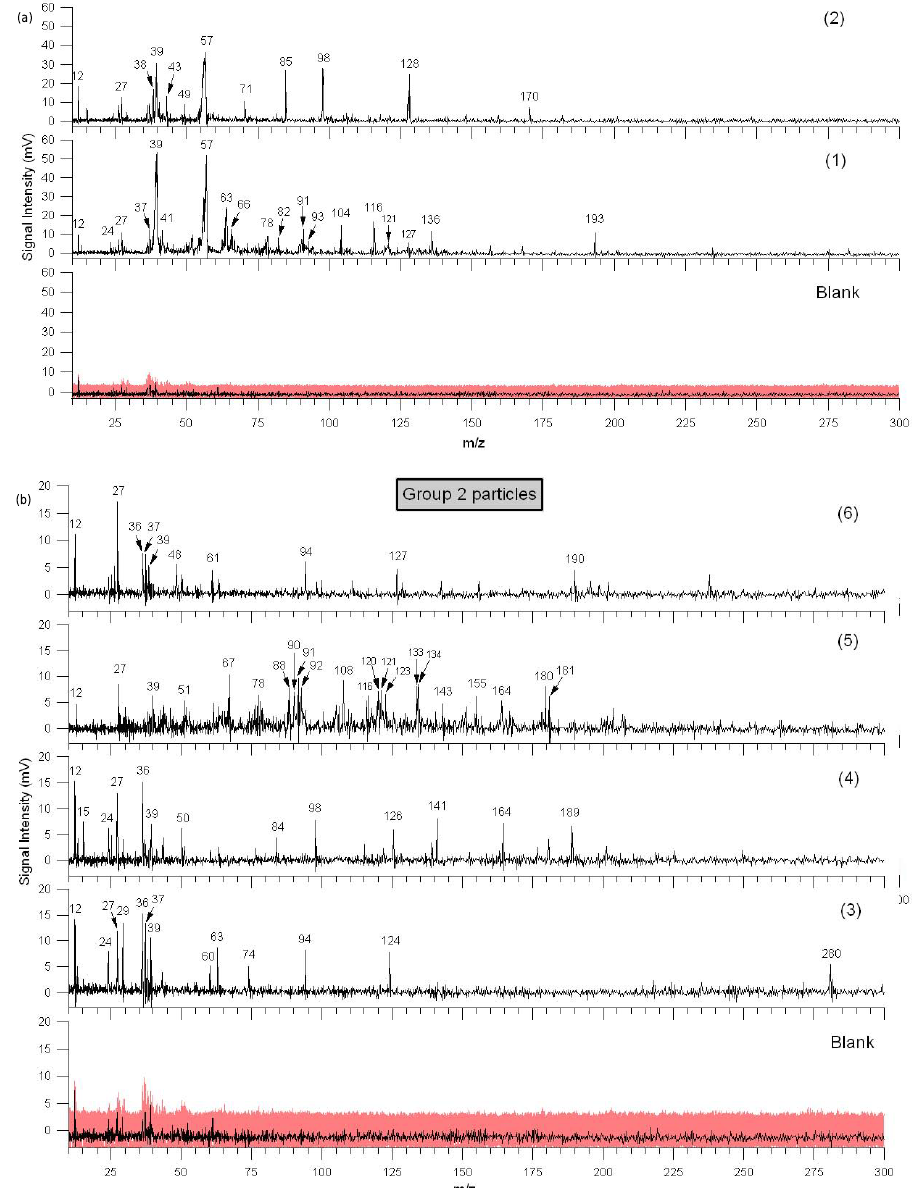
Fig. 10. Six single particle mass spectra of SOA produced by ozonolysis of indene in the smog chamber CESAM (group 2 particles). (a) and (b) have different ordinate scaling. The blank level is determined to be at 4mV (indicated as red shaded zone in the lowest panels). See text for further